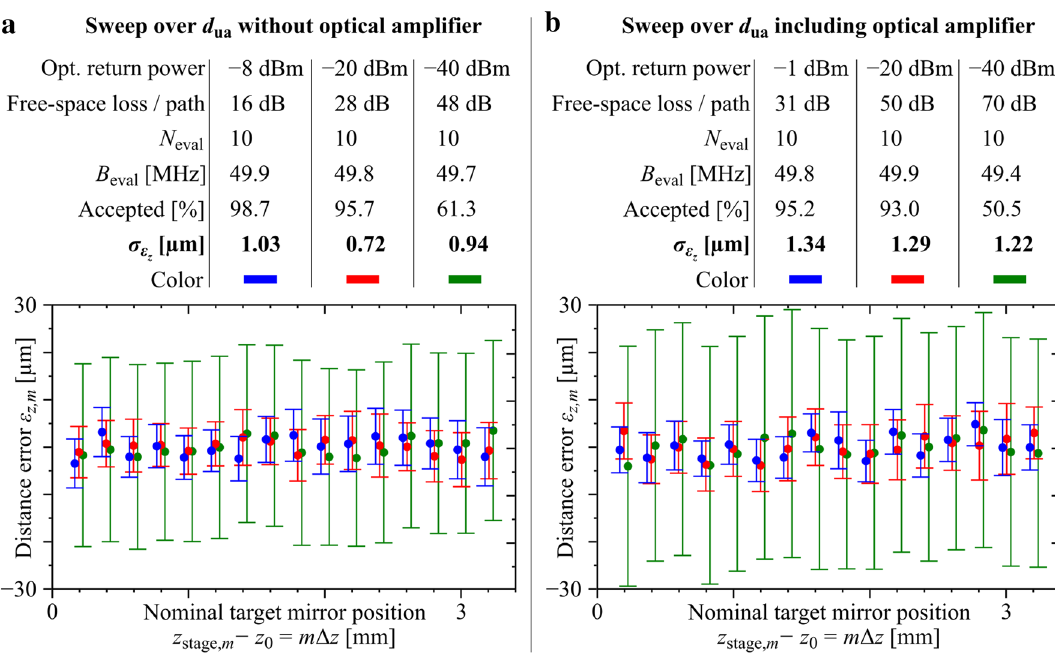
Figure 4. Unambiguity-distance sweep for varying free-space losses with and without EDFA, see Fig. 2a for the underlying experimental setup and Section ‘Detailed description of experimental setups’ of the Supplementary Information for further details. ( a ) Unambiguity-distance sweep without optical amplifier. The table lists the optical return power, the associated optical loss per path, the amount of considered pulse repetition periods per distance data point N eval , the corresponding evaluation bandwidth B eval averaged over the measurement series, the percentage of accepted data points, and the variance σ ε of the distance errors ε z , m for three different z measurement series. The figure shows the residual distance error of each target mirror position, i.e., the difference between the set and the mean of the measured position as a function of the nominal target mirror position z stage, m − z 0 = m (cid:31) z as set by the stage over the unambiguity distance of the system. Error bars indicate the standard deviation σ z of the point-wise computed difference between the beam-path length to the static tar , m reference mirror and the beam-path length to the target mirror. For better readability, the data points and error bars belonging to the same position z stage, m − z 0 = m � z , m = 1 . . . 16, � z = 200 µ m of the target mirror are slightly offset horizontally with respect to each other. ( b ) Same as ( a ), but with an EDFA acting as optical booster amplifier. Further details on the experiment and the data evaluation can be found in Section ‘Evaluation of unambiguity-distance sweep with fiber drift compensation’ of the Supplementary